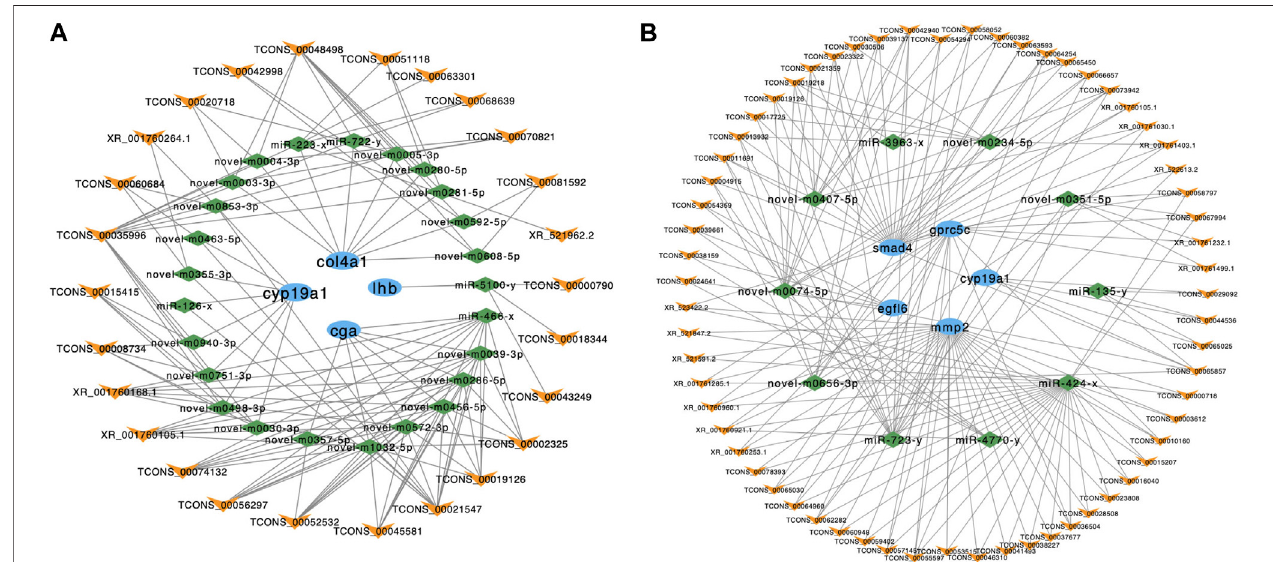
FIGURE6| TheceRNAinteractionnetworksinthebrainandpituitary. (A) TheceRNAnetworkof cyp19a1 , col4a1 , lhb and cga inthebrain. (B) TheceRNAnetwork of smad4 , gpcr5c , cyp19a1 , mmp2 and eg fl 6 in the pituitary. The blue ellipses represent mRNAs, the green diamonds represent miRNAs, and the yellow “ V ” symbols represent lncRNAs.